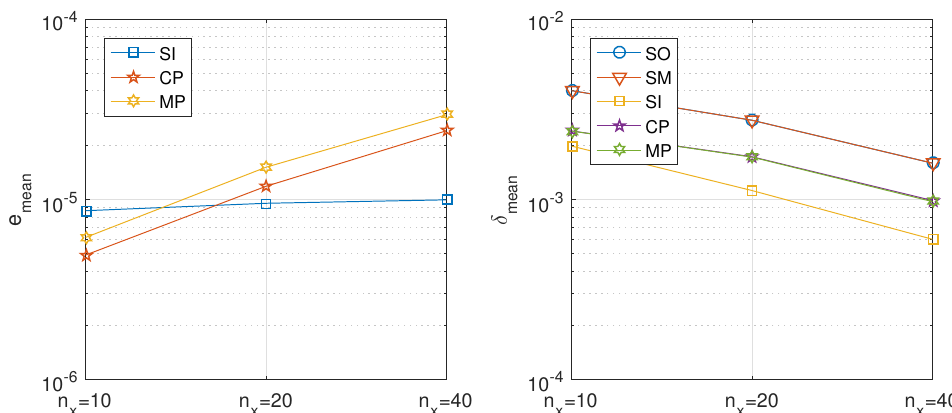
Figure 4. Diffusion problem, directional decomposition. Precision of the proposed methods: sequential iterative SI, classical parallel CP, and modern parallel MP, compared with the classical ones: sequential operator SO and Strang–Marchuk SM, with second order approximations for the spatial derivatives with 320 time steps and different number of spatial steps.